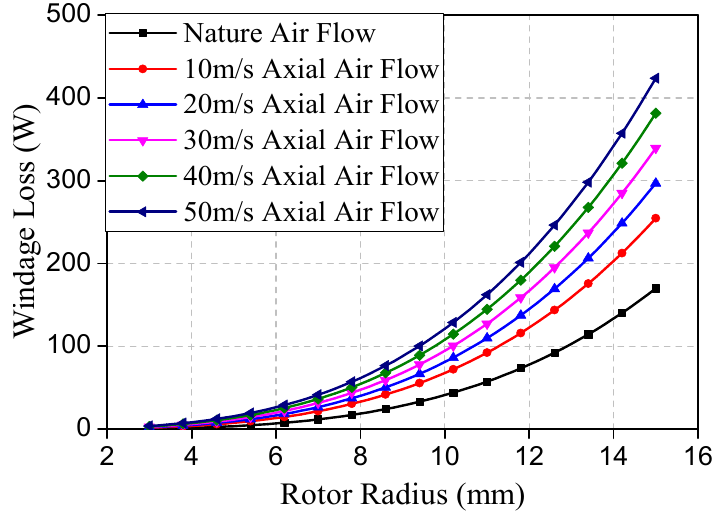
Figure 10. Windage loss under different cooling conditions.